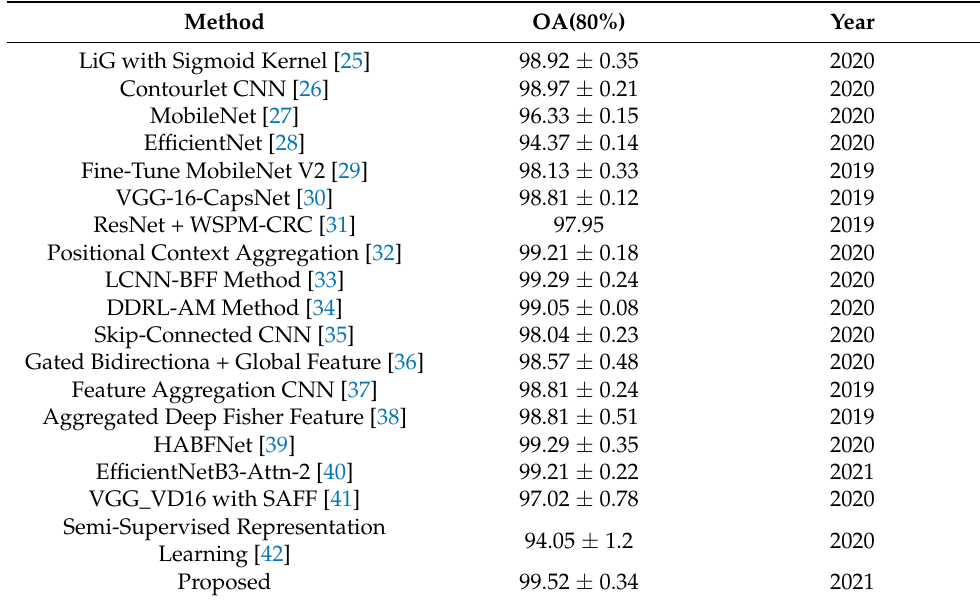
Table 4. OA(%) of eighteen methods and the LCNN-CMGF method at the training ratio of 80% in the UCM21